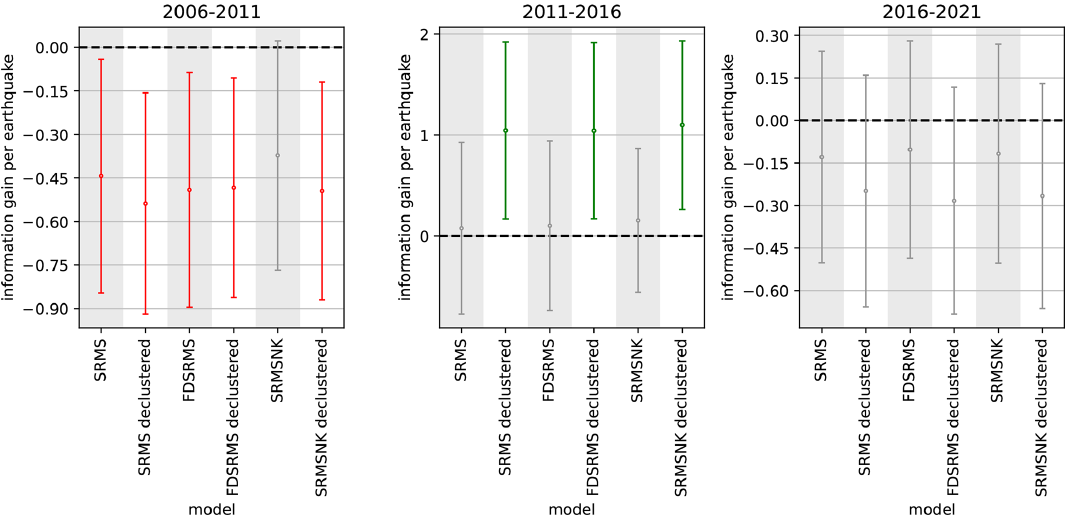
Figure 7. T-test results for the inlabru models showing information gain per earthquake relative to the full Helmstetter et al. (2007) model (Helmstetter aftershock in Fig. 6) for three time periods. Red indicates forecasts are worse in terms of information gain and green indicates forecasts performing better than the benchmark forecast. Grey forecasts are not significantly different in terms of information gain. Models include combinations of smoothed past seismicity (MS), strain rate (SR), fault distance (FD) and fault slip rates